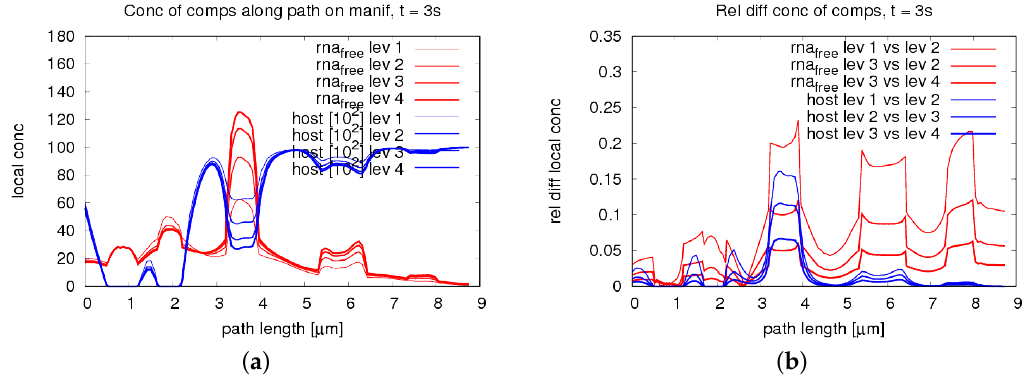
Figure A8. Grid convergency behavior of the concentrations of free HCV RNA and host factor along the long path around the ER and web surface at time t = 3 s: ( a ) concentrations at different levels; and ( b ) relative